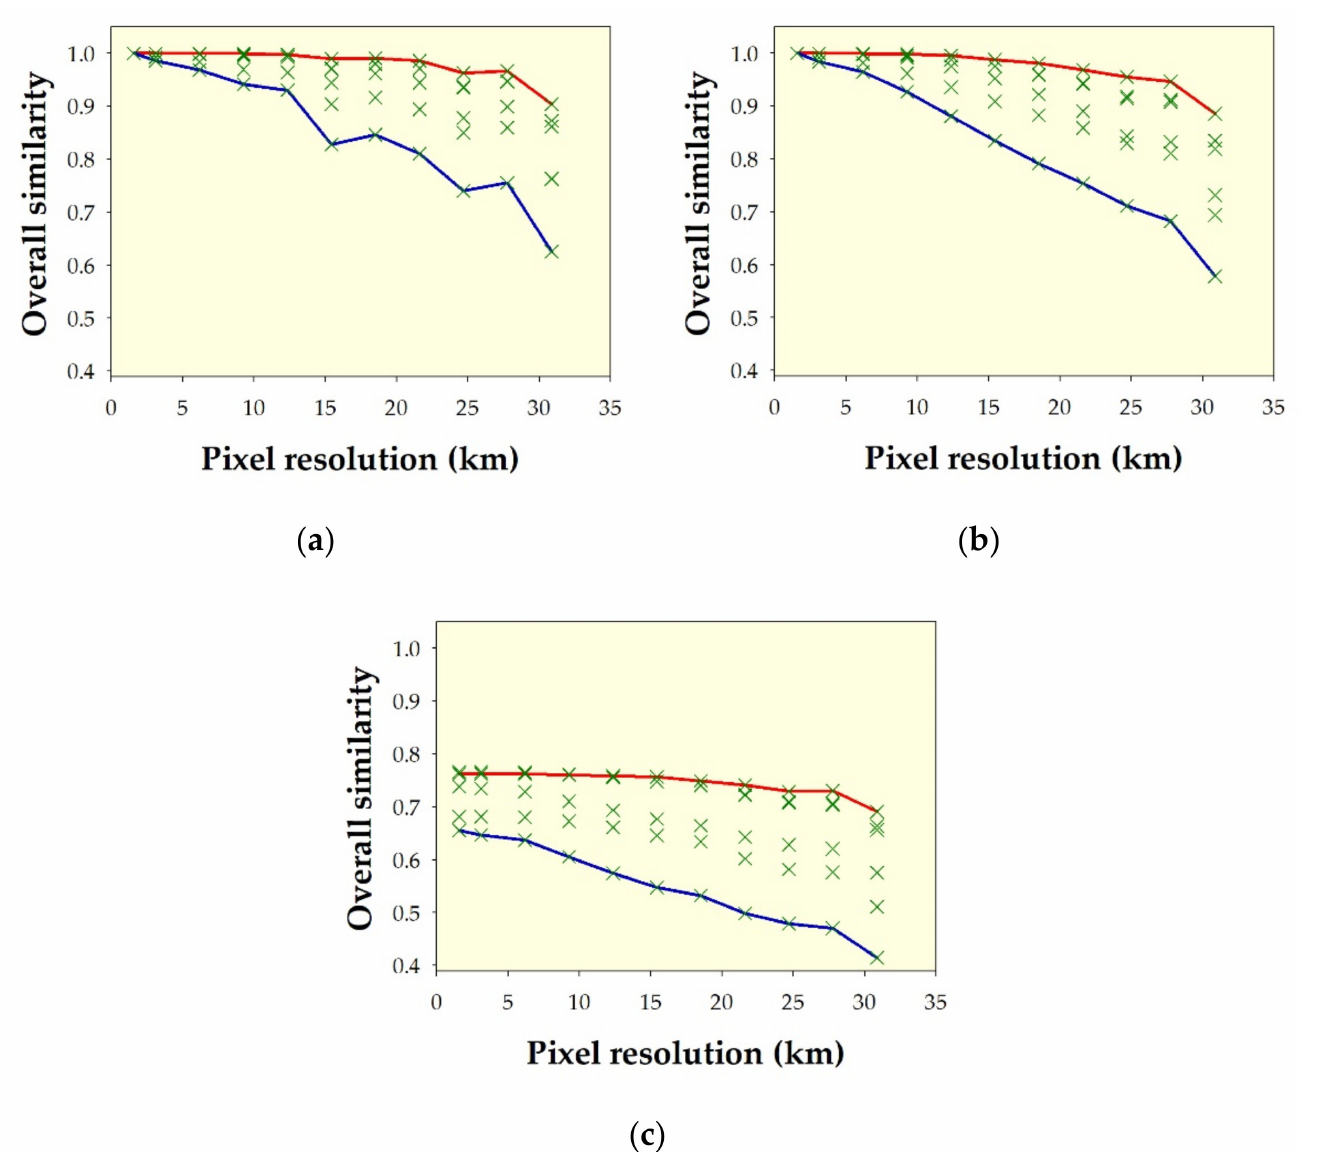
of Figure 16, the upper edge of the envelopes—indicating the Fidelity metric (red line)— seemed relatively insensitive to changes of MODIS-detection thresholds, Table 3 suggests that a threshold of about 100 was optimal. However, the lower edge of the envelopes— indicating the metric of Soergel–Ruzicka–Tanimoto (blue line)—suggests that the most optimal MODIS detection threshold was about 80, with regard to spatial pattern similarity.